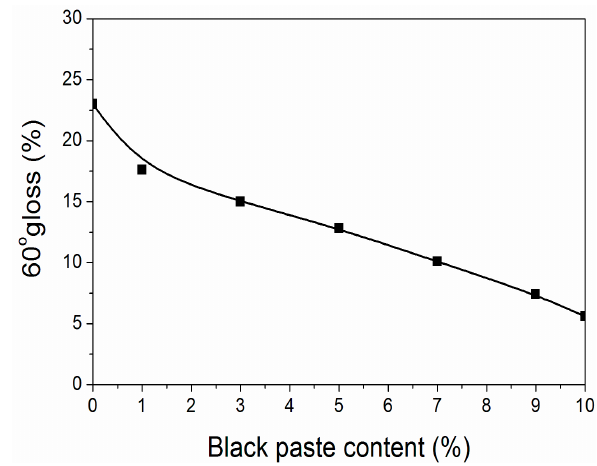
Figure 1. Effect of black paste content on gloss of the coatings.